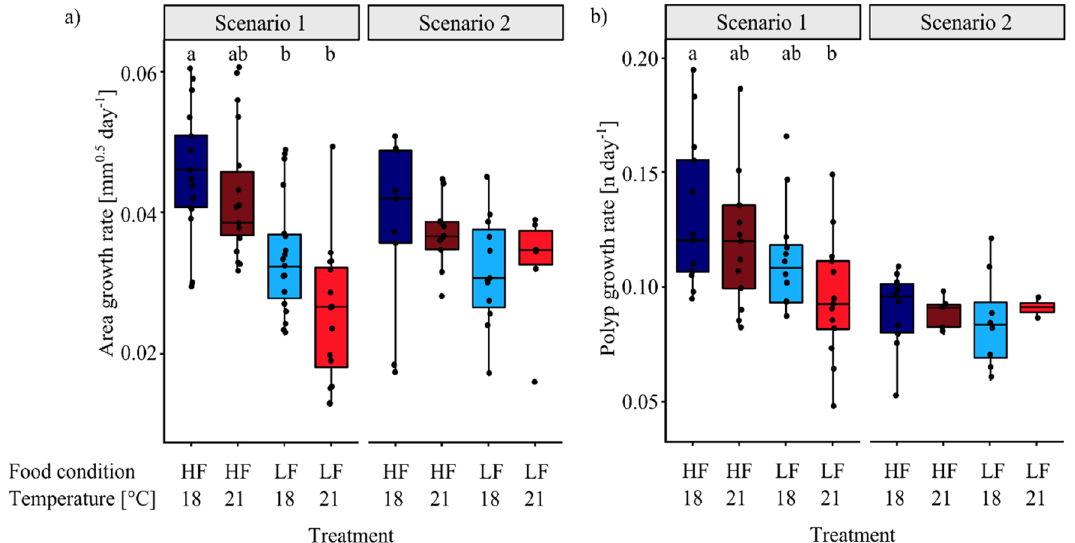
Figure 2. Area growth rates ( a ) and polyp growth rates ( b ) of juvenile H. echinata in two experiments, scenario 1(left) and 2 (right); median ± SD . HF = high food (dark blue and red boxes), LF = low food (light blue and red boxes), 18 °C = control temperature (blue boxes), 21 °C = high temperature (red boxes). All treatments in scenario 2 contained an extra temperature step of + 1.5 °C for six hours daily (see also Fig. 3). Significant differences between treatments are marked by lower